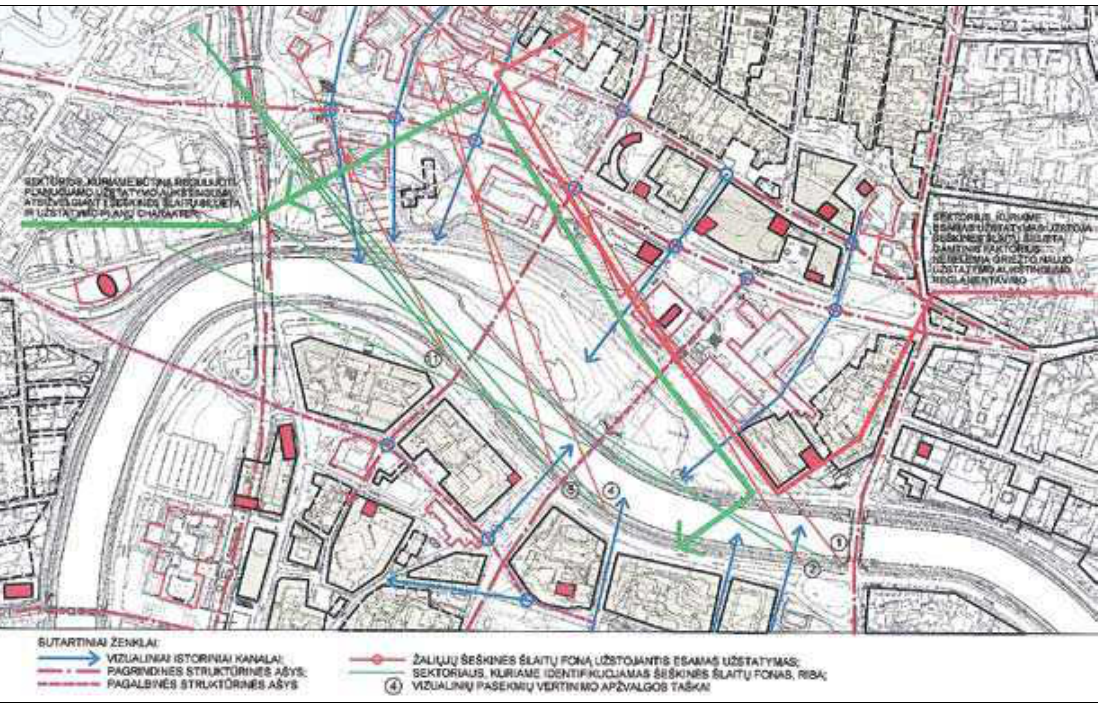
Fig. 3. Prognosis of visual outcome from the viewpoints of the lower terrace